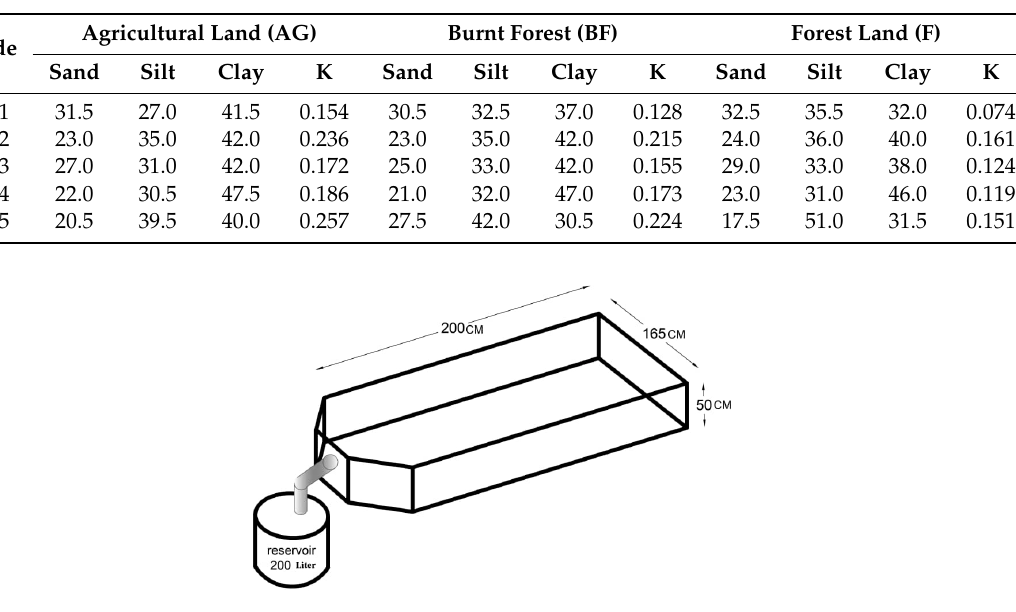
Table 2. Soil texture and K value in the studied locations (SY1-SY5) for three land uses (agricultural land (AG), burnt forest (BF), and forest land (F)).